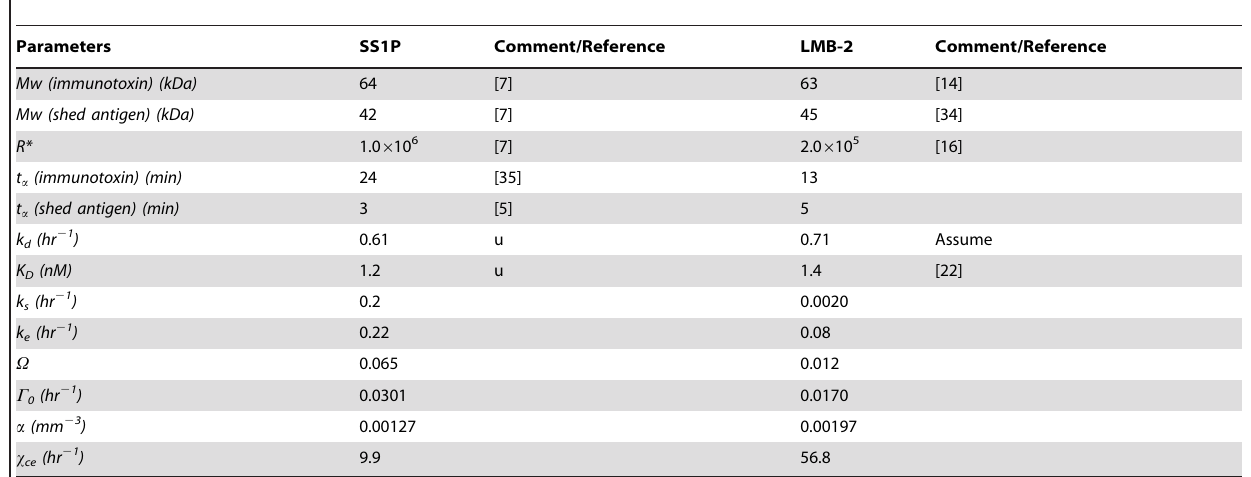
Table 3. Parameters that were changed for